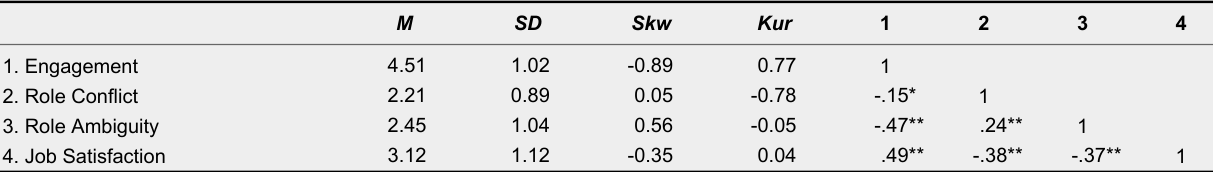
Descriptive Statistics and Correlations of All Study Scales